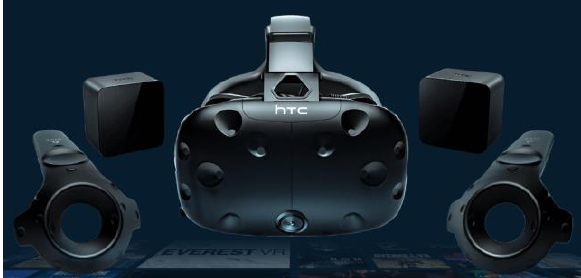
Figure 4. HTC Vive Virtual Reality Helmet